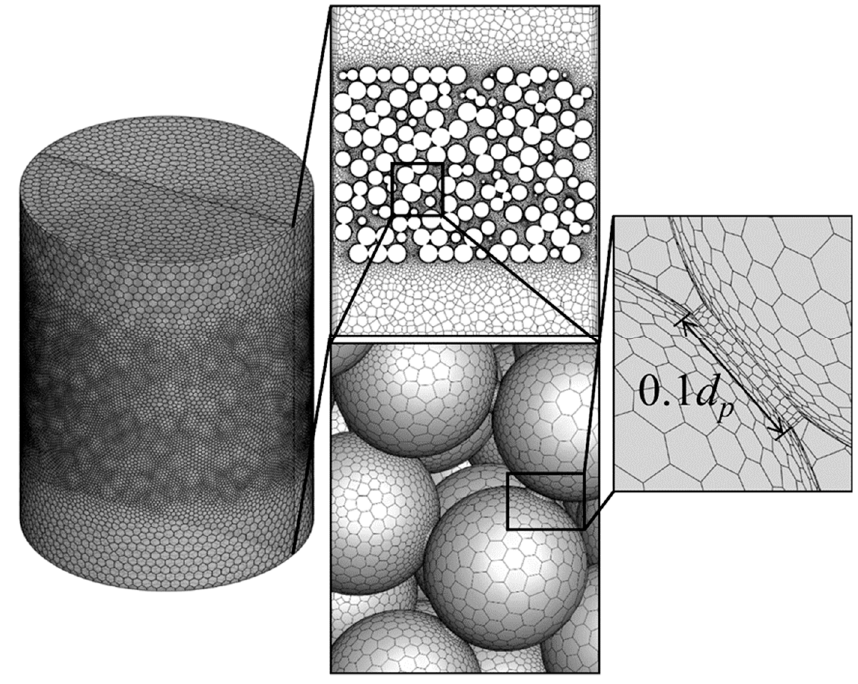
Figure 3. Schematic diagram of grid and contact treatment.